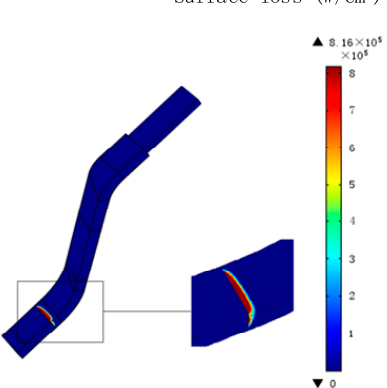
Figure 8. Surface loss distribution of the linear corona protection layer.